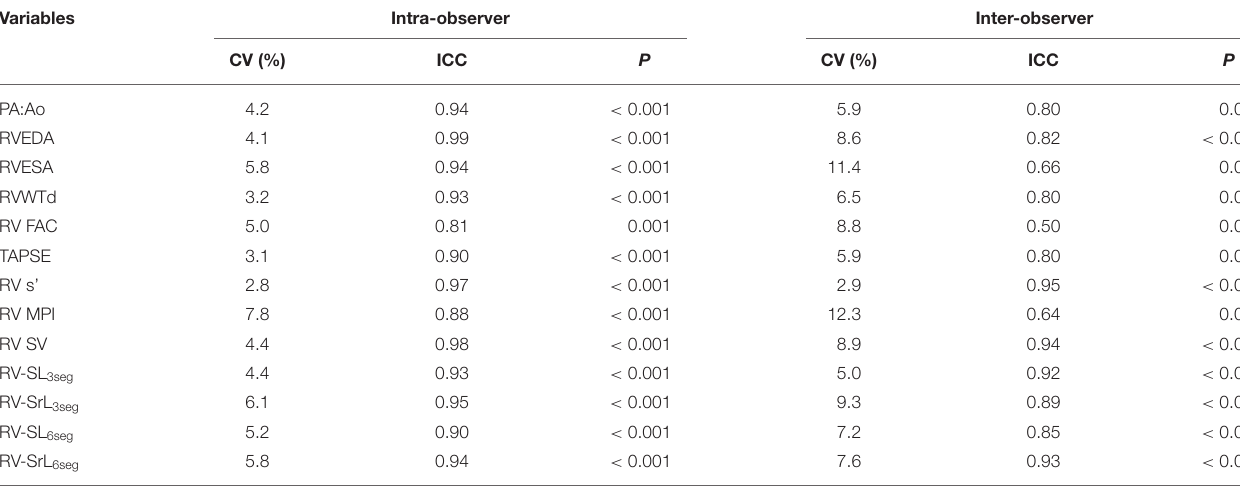
3seg, only right ventricular free wall analysis; 6seg, right ventricular global analysis; CI, confidence interval; CV, coefficient of variation; ICC, intra- or inter-class correlation coefficients; PA:Ao, pulmonary artery to aortic diameter ratio; RV FAC, right ventricular fractional area change; RV MPI, right ventricular myocardial performance index; RV s’, tissue Doppler imaging-derived peak systolic myocardial velocity of lateral tricuspid annulus; RV SV, right ventricular stroke volume; RVEDA, end-diastolic right ventricular area; RVESA, end-systolic right ventricular area; RV-SL, right ventricular longitudinal strain; RV-SrL, right ventricular longitudinal strain rate; RVWTd, end-diastolic right ventricular wall thickness; TAPSE, tricuspid annular plane systolic